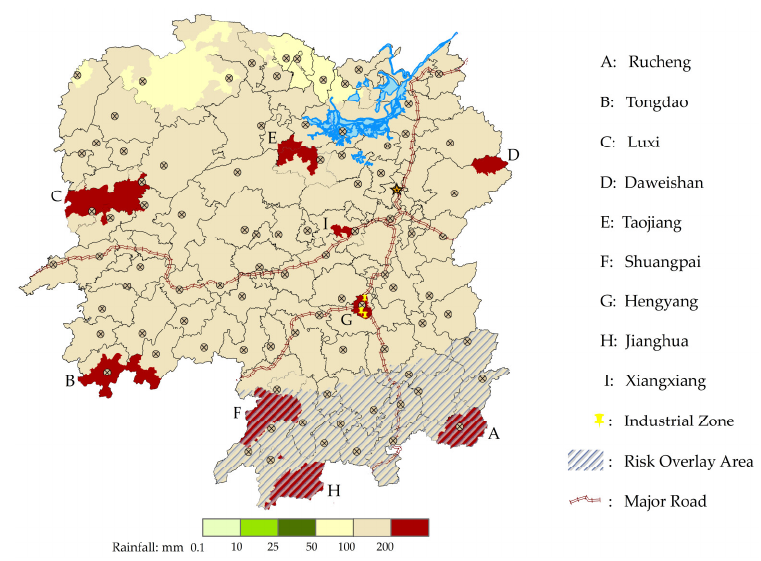
Figure 8. Cases of flood rainfall in Hunan Province, China.